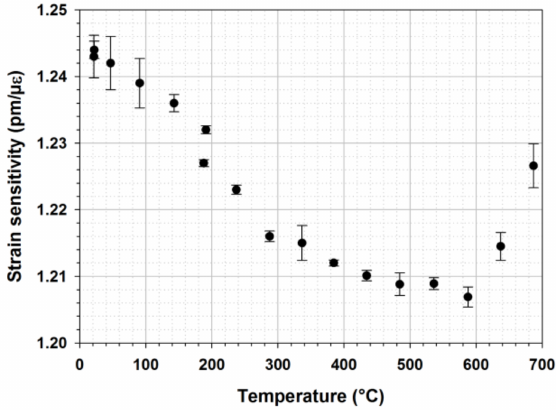
Figure 16. Strain sensitivity of a regenerated FBG for increasing operating temperatures up to 700 ◦ C (~50 ◦ C increments between two consecutive